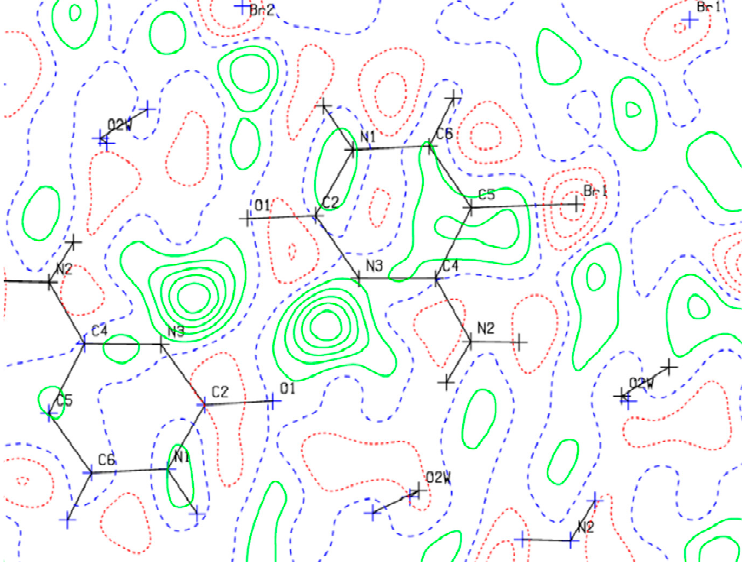
Figure 10. Visualization of the difference Fourier map through C2, N3, and C4 atoms of compound ( II ), revealing the hydrogen atom at the N3 ring position. Electron density is in the range − 0.20 (blue line)–0.60 e/Å 3 (green